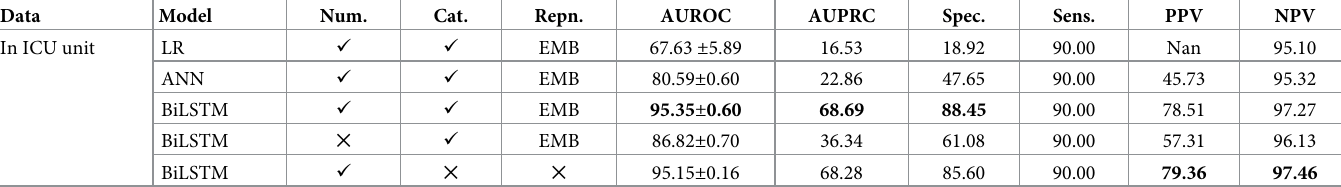
Table 8. Decompensation risk prediction in